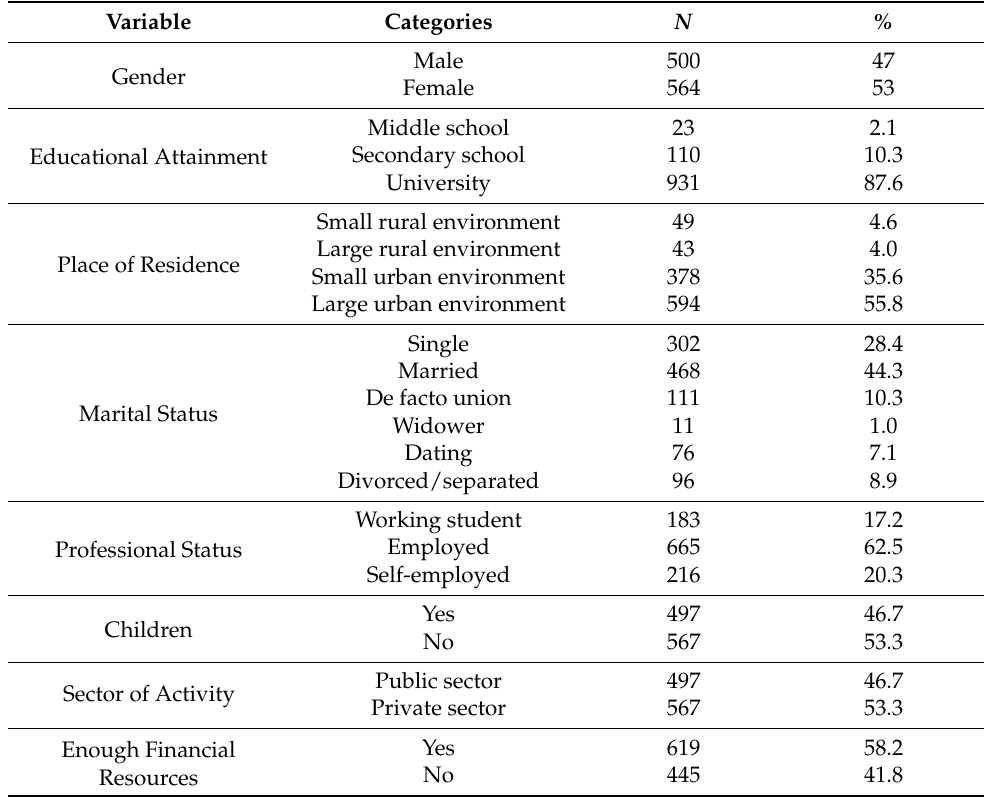
Table 1. Sociodemographic characteristics ( N = 1064; M age = 40.66; SD = 12.02).